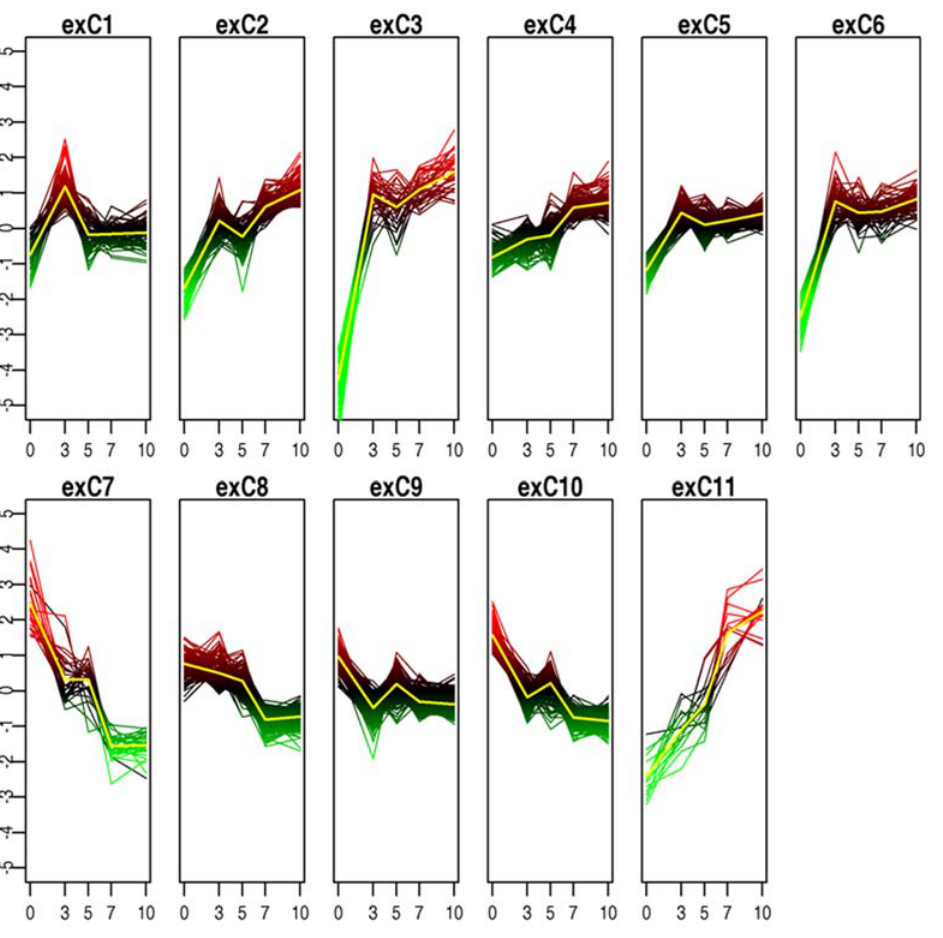
Figure 2. K-means clustering of genes differentially expressed during keratinocyte differentiation. The mean abundance of each transcript at each of the 5 time points is shown for each of the 11 clusters of gene expression. Abundance levels are log base 2 with mean 0.